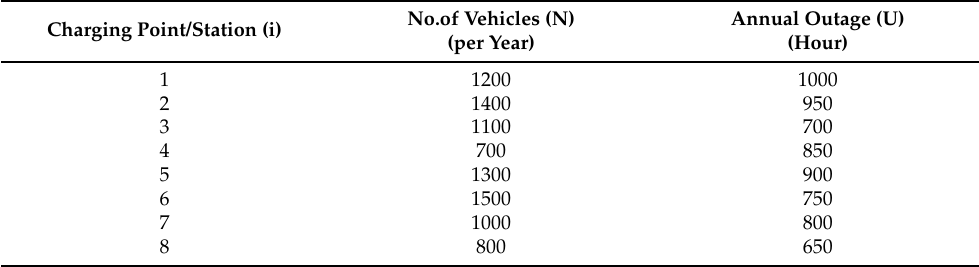
Table A2. Charging Station